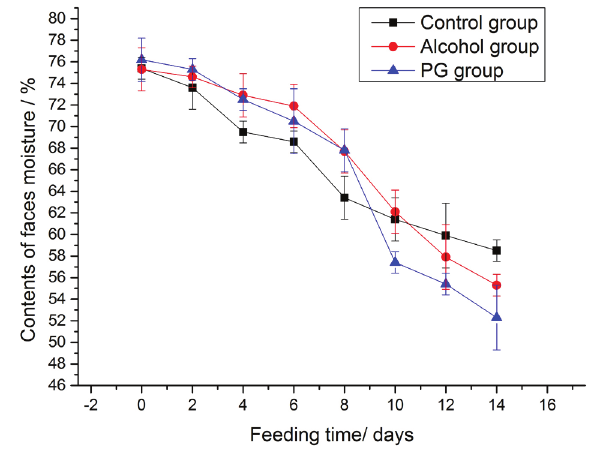
FIGURE 2 - Effect of PG on the contents of feces